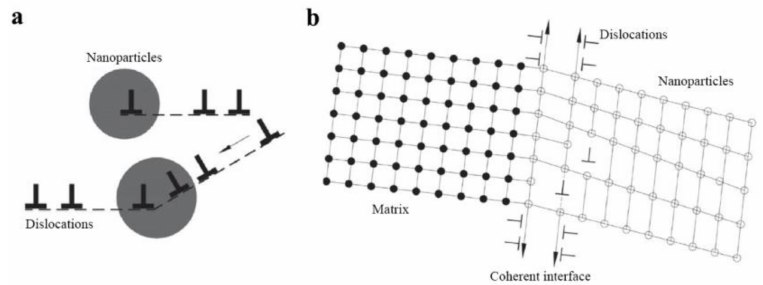
Figure 1. Strengthening mechanisms of the in-situ nanoparticles being coherent to the matrix [38]. ( a ) when slipping dislocations meet these nano-scale coherent interfaces, they will slip along the coherent interface and enter into the nanoparticles (Some stay inside the nanoparticles, while others pass through the interface and continue slipping); ( b ) schematical diagram of dislocations movement around the coherent